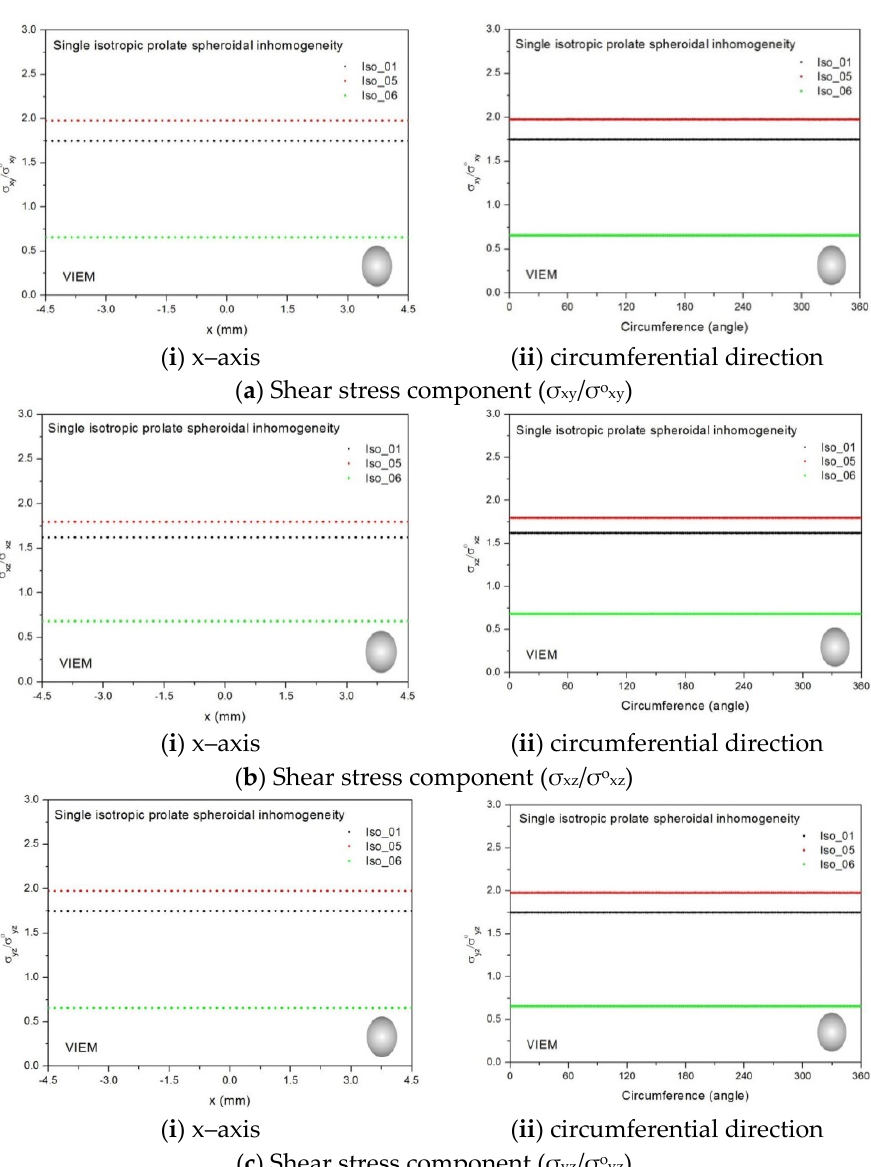
Figure 25. VIEM results for the normalized shear stress components ( a ) σ xy / σ oxy , ( b ) σ xz / σ oxz and ( c ) σ yz / σ oyz along ( i ) the x–axis inside and ( ii ) the circumferential direction of the isotropic prolate spheroidal inclusions (Iso_01, Iso_05 and Iso_06) with a/b = c/b = 0.75 (b = 6 mm) under remote shear loading ( σ oxy , σ oxz and σ oyz ).